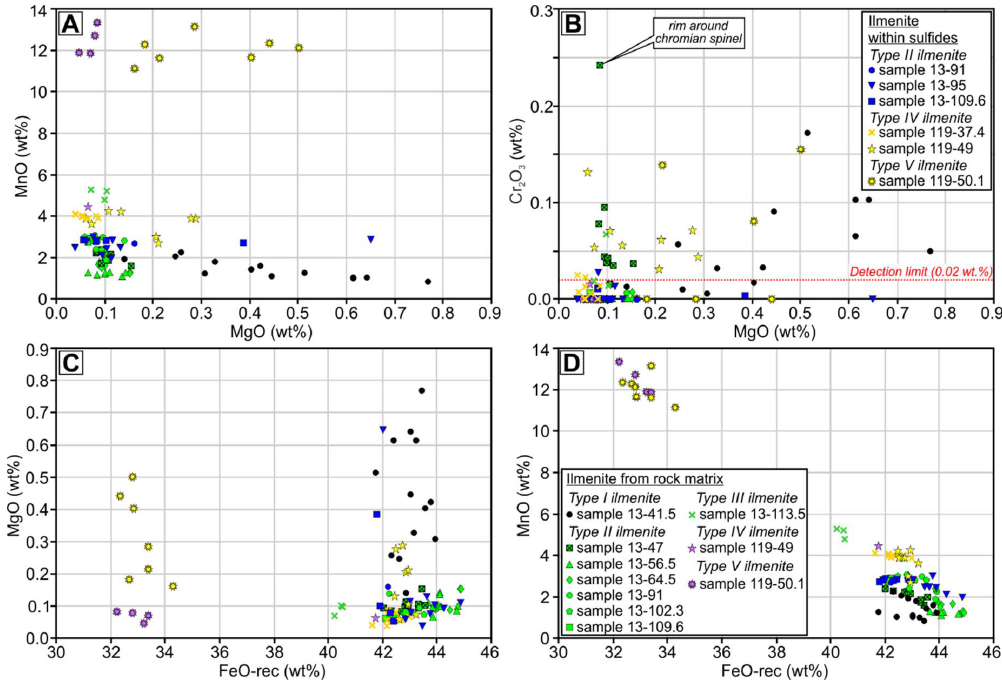
Figure 5. Plots of MnO (wt%)–MgO (wt%) ( A ), Cr 2 O 3 (wt%)–MgO (wt%) ( B ), MgO (wt%)–FeO-rec (wt%) ( C ), and MnO (wt%)–FeO-rec (wt%) ( D ) for ilmenite from the metamorphosed mafic-ultramafic rocks of the Sedova Zaimka intrusion. The FeO-rec values are FeO contents recalculated from FeO total , in accordance with Carmichael [52]. Data from Table